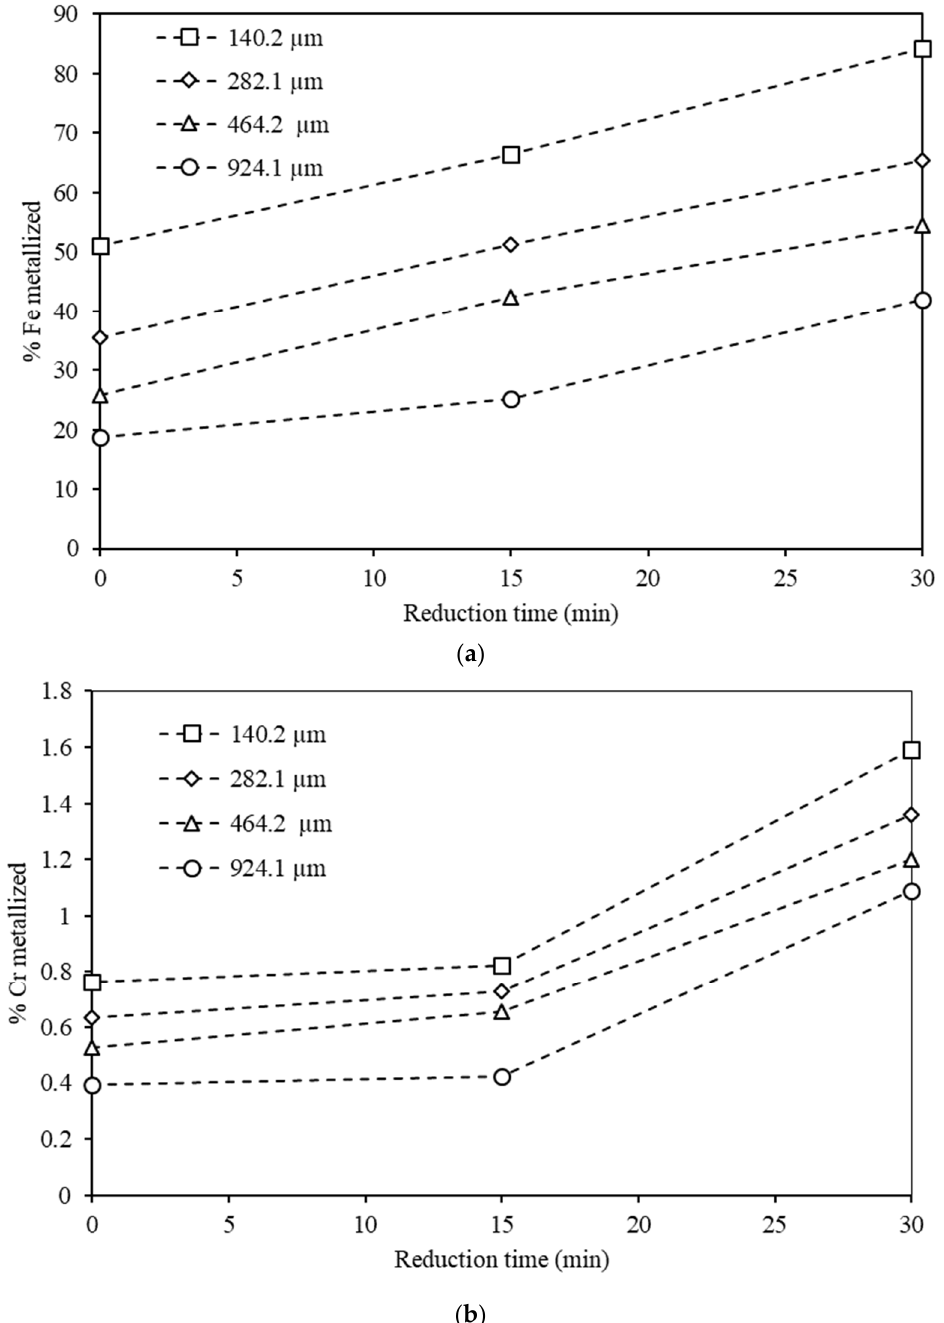
Figure 10. The effects of reduction time on ( a ) Fe and ( b ) Cr metalization during isothermal treat- ment at 1100 °C. at 1100 ◦